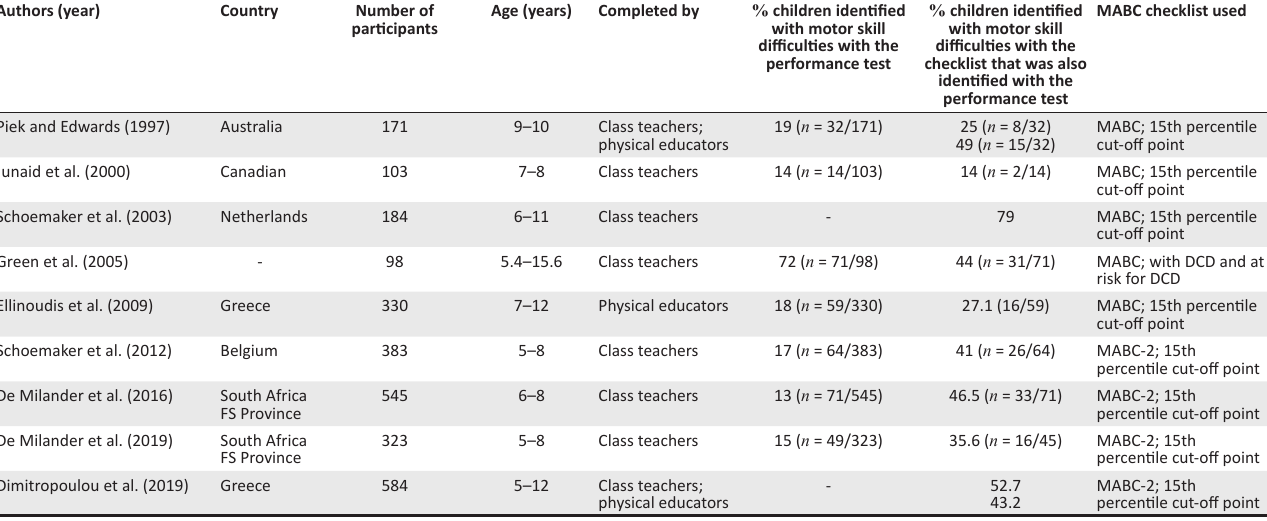
TABLE 1: Findings on the percentage of children with motor skill difficulties identified by teachers using the movement assessment battery for children original and second edition checklist. Authors (year) Country Number of Age (years) Completed by % children identified participants with motor skill